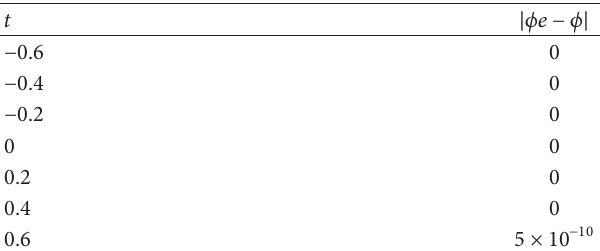
Table 6: The HAM results for 𝜙 (𝑥,𝑦,𝑡) in comparison with the analytical solution with initial conditions